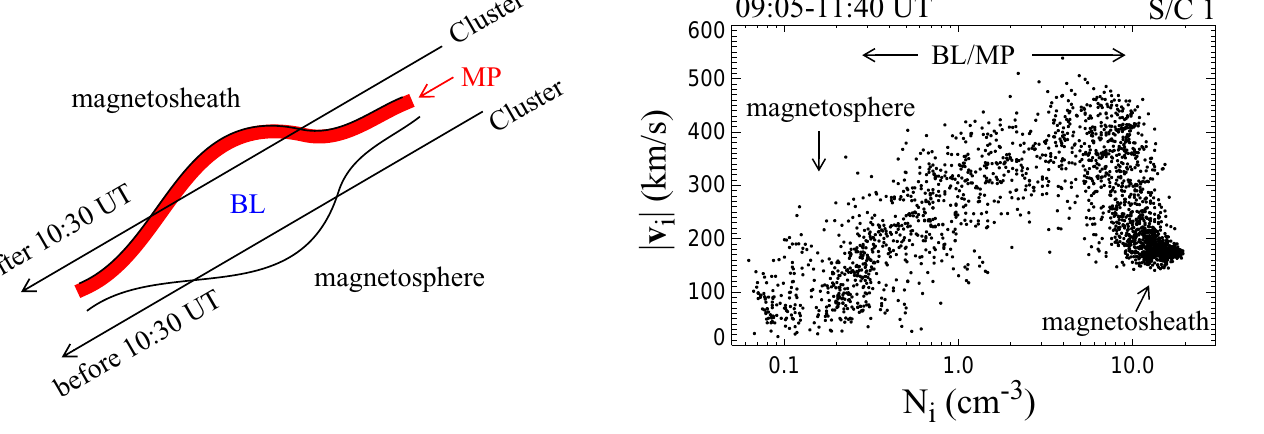
Fig. 3. Effective partial crossings by Cluster through the MP/BL before and after 10:30 UT. Most crossings before 10:30 UT encountered the BL but did not encounter the MP and magnetosheath whereas crossings after 10:30 UT encountered the MP and BL but did not encounter the magnetosphere, implying travelling blobs.